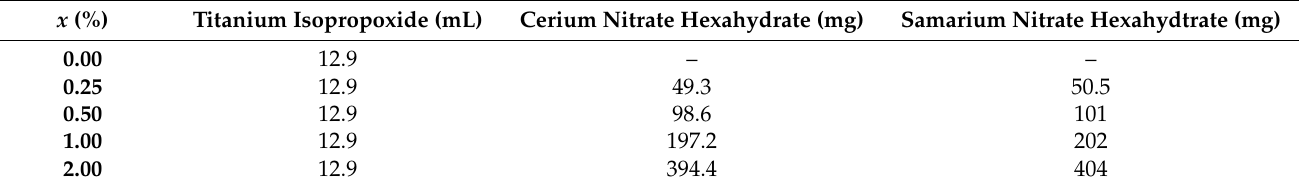
Table 3. Weight and/or volume of